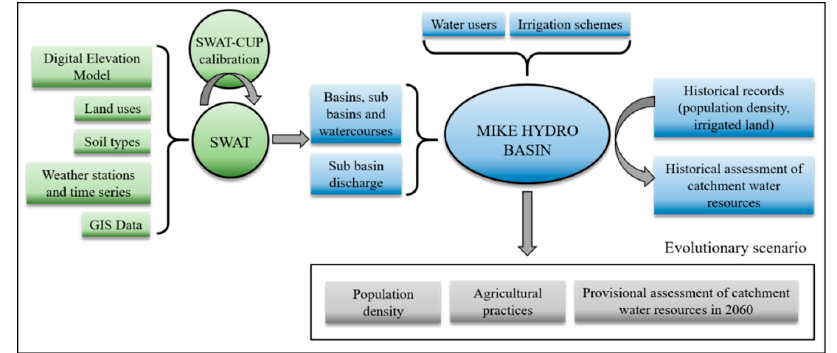
Figure 2. The process and concept for the Soil and Water Assessment Tool (SWAT) and MIKE HYDRO Basin